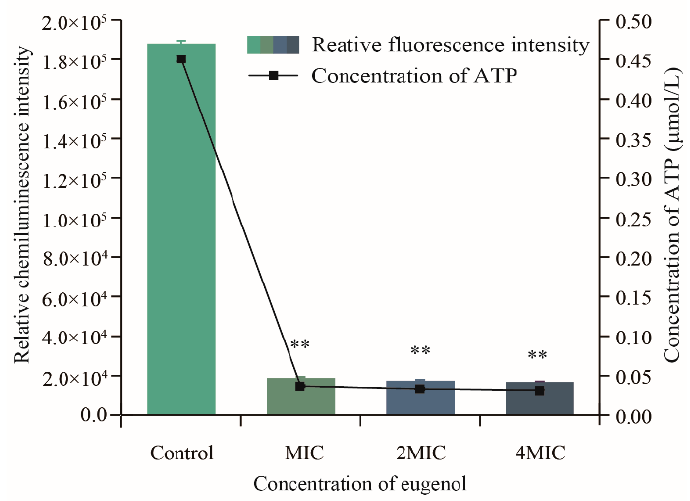
Figure 6. The effects of eugenol on intracellular ATP concentration of Sh. flexneri . ** indicates statistical significance of p < 0.01 compared with the control.